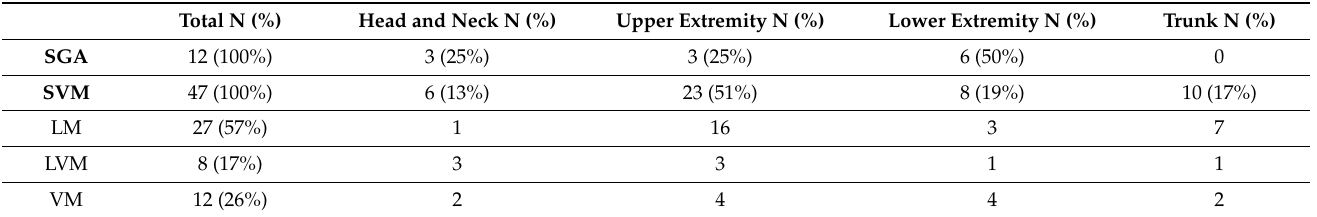
2 4 Legend: SGA = subcutaneous granuloma annulare; SVM = subcutaneous vascular malformations; LM = lymphatic malformation; LVM = lymphatico-venous malformation; VM = venous malformation; N = number of